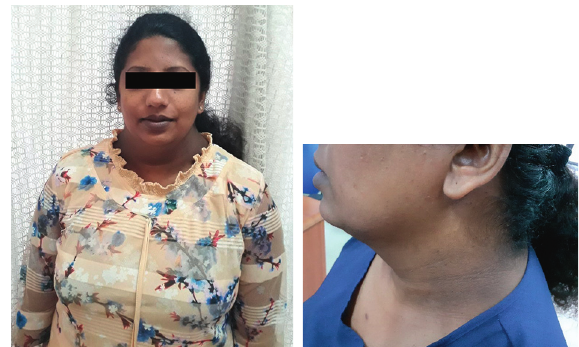
Figure 1: The index patient demonstrating central obesity and acanthosis